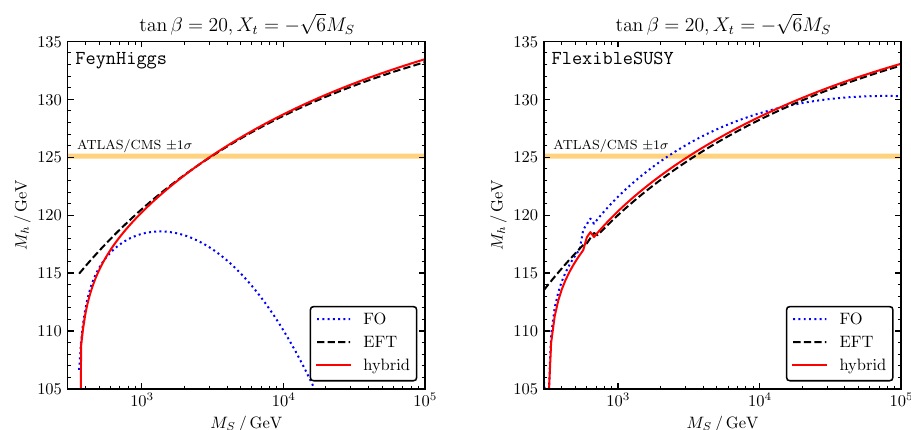
The comparison between the different curves in Fig. 3 shows that, both in FeynHiggs and in FlexibleSUSY , the hybrid calculation does indeed agree with the FO cal- culation at small M S and with the EFT calculation at large M S . The small residual deviation between the hybrid and EFT curves for FeynHiggs at large M S is due to two- loop corrections involving the EW gauge couplings that are included in the pure EFT calculation but not in the EFT com- ponent of the hybrid calculation. The kinks visible in the FlexibleSUSY curves around M S ≈ 750 GeV originate from a switch of the mass hierarchy used to approximate the three-loop corrections in the calculation of Refs.